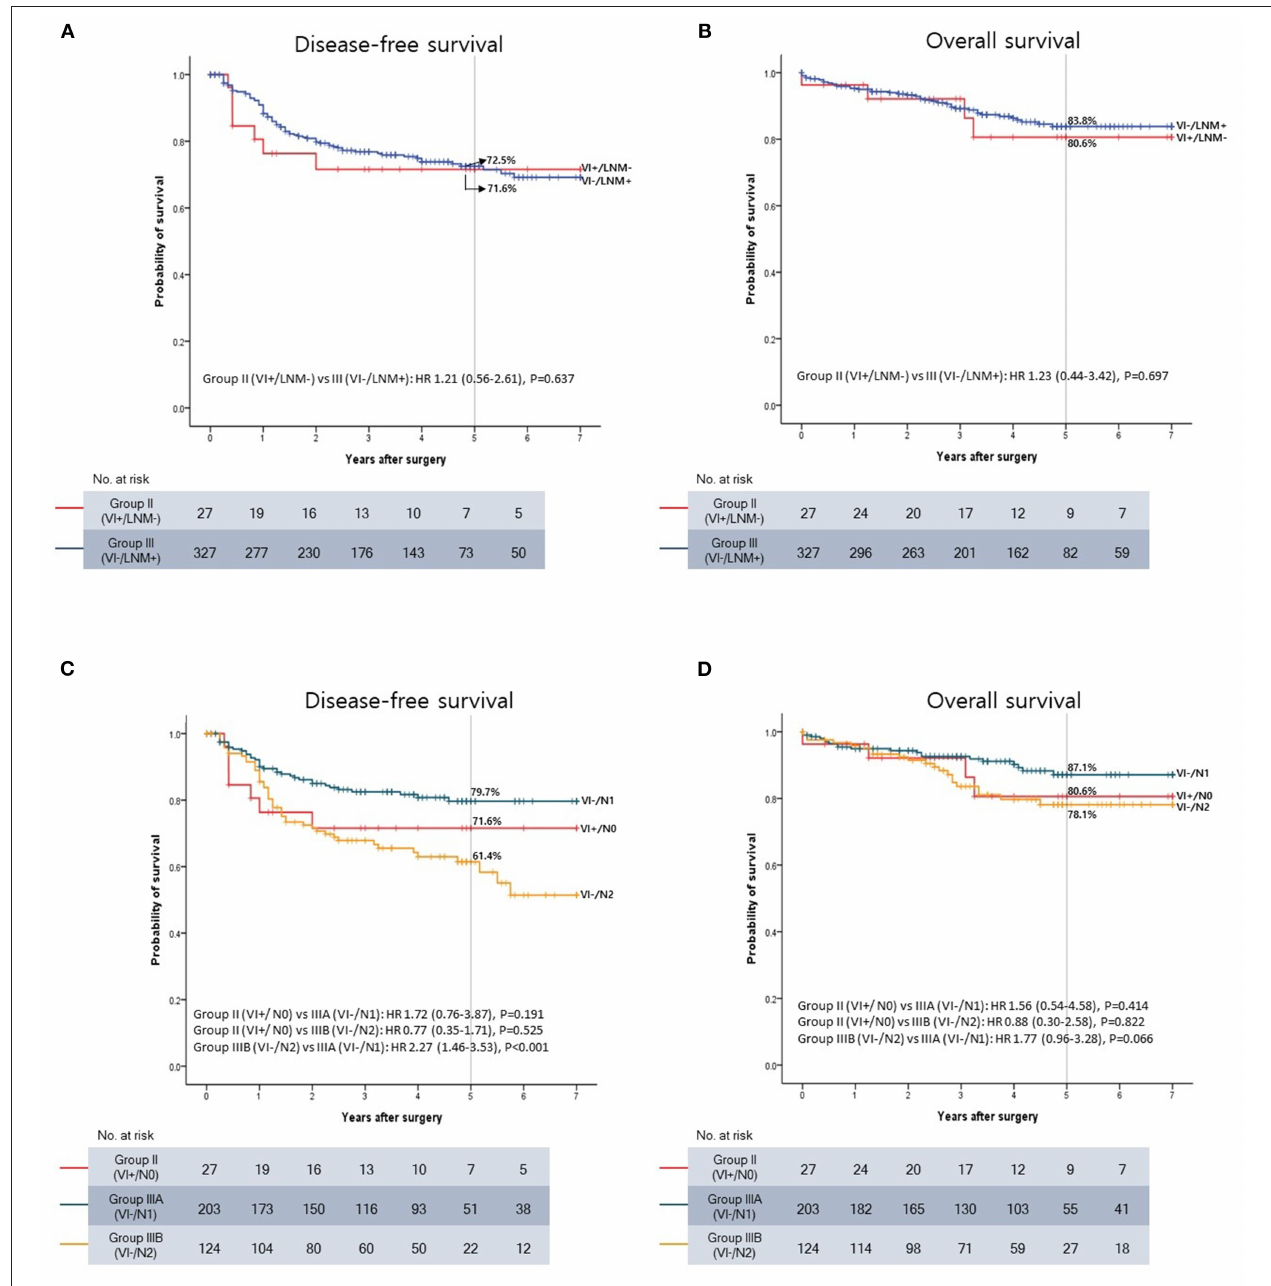
FIGURE 4 | Kaplan-Meier survival curve. (A) Disease-free survival (DFS) between VI + /LNM- and VI-/LNM + patients. (B) Overall survival (OS) between VI + /LNM- and VI-/LNM + patients. (C) DFS between VI + /LNM-, VI-/N1, and VI-/N2 patients. (D) OS between VI + /LNM-, VI-/N1, and VI-/N2 patients.